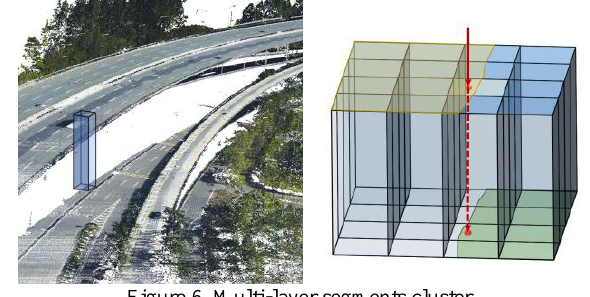
Figure 6. Multi-layer segments cluster